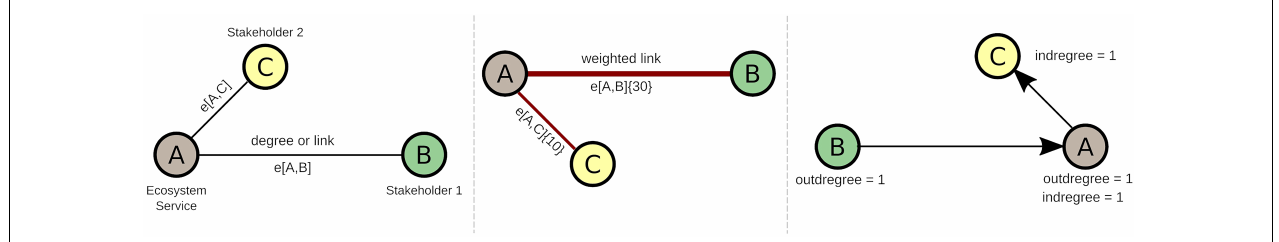
FIGURE 2 | Diagram of a minimum socio ecological network (SEN) configuration for simple, weighted and directed edges or links, where a link between two nodes is realized when each either obtains or transfers an economic benefit derived from an ecosystem service